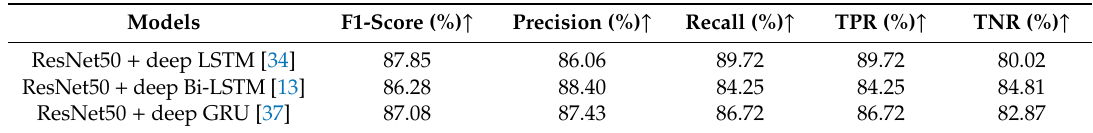
Table 3. Performance comparison of LSTM, Bi-LSTM, and gated recurrent unit (GRU) for finding an optimal teacher model. Deep LSTM model that includes three LSTM layers 1 .